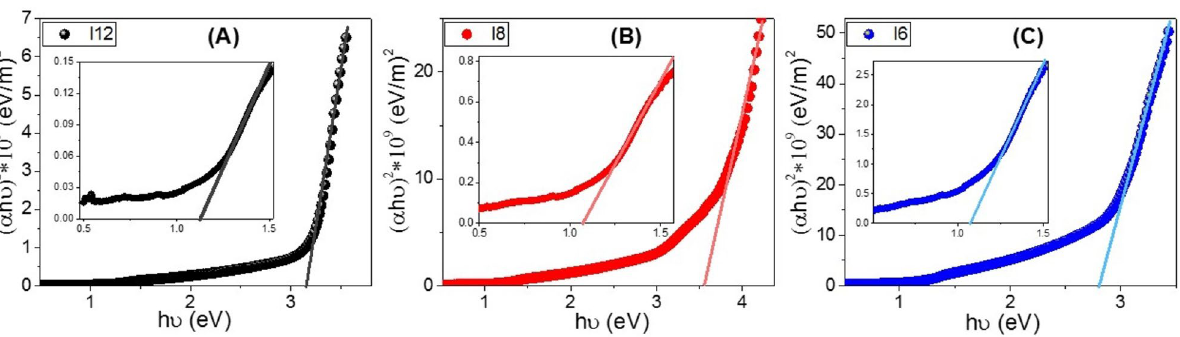
Figure 7. Calculation of energy gap for ( A ) I-6, ( B ) I-8 , and ( C ) I-12 in liquid crystal phase designed at 140